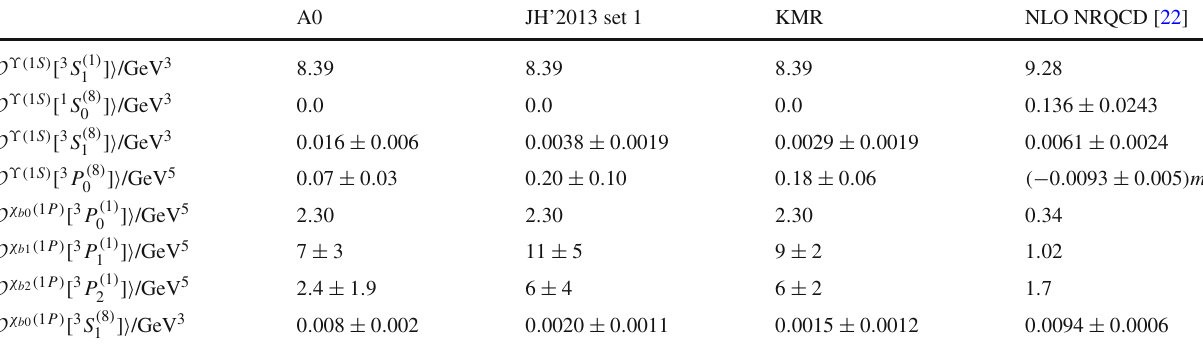
Table 1 The NMEs for the ϒ( 1 S ) and χ b ( 1 P ) mesons as determined from our fit at p cut the NLO NRQCD [22] are shown for comparison A0